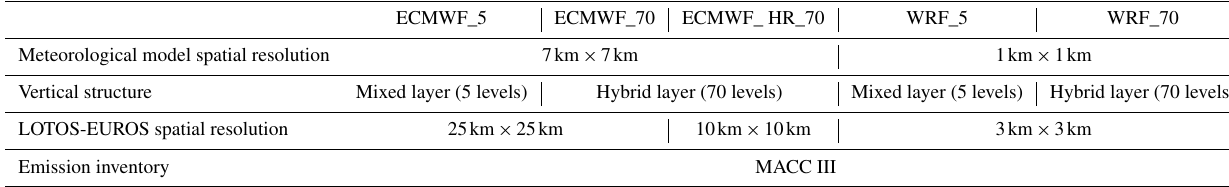
Table 1. Summary of the LOTOS-EUROS v2.0 model runs and settings performed for this work.